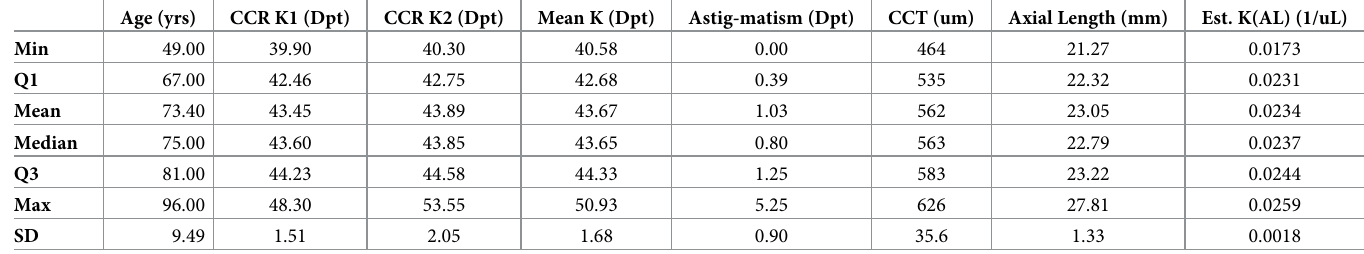
Table 2. Subject measurements descriptive